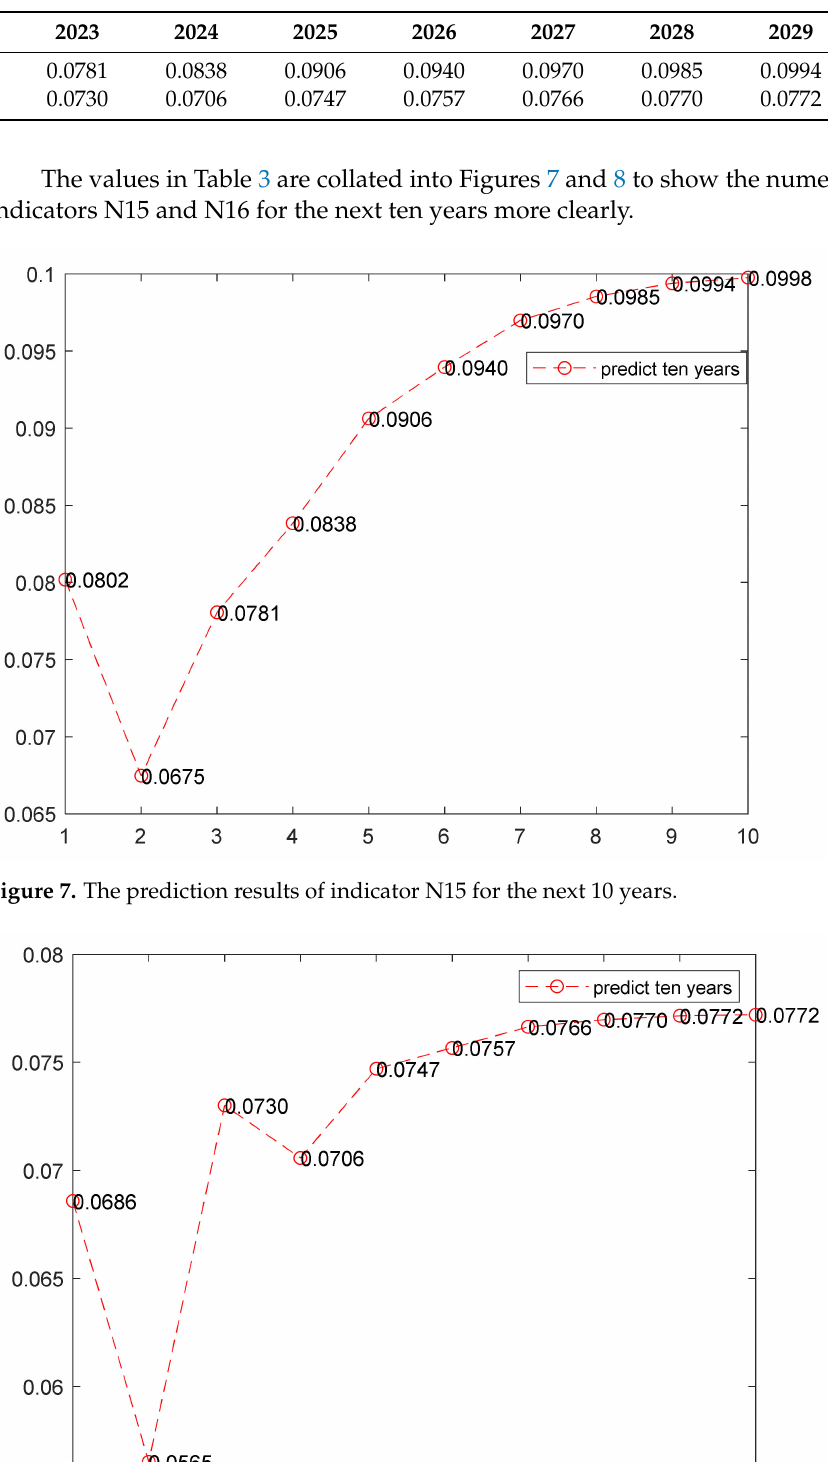
Table 3. The predicted values of the influencing factors N15 and N16 for the next 10 years.